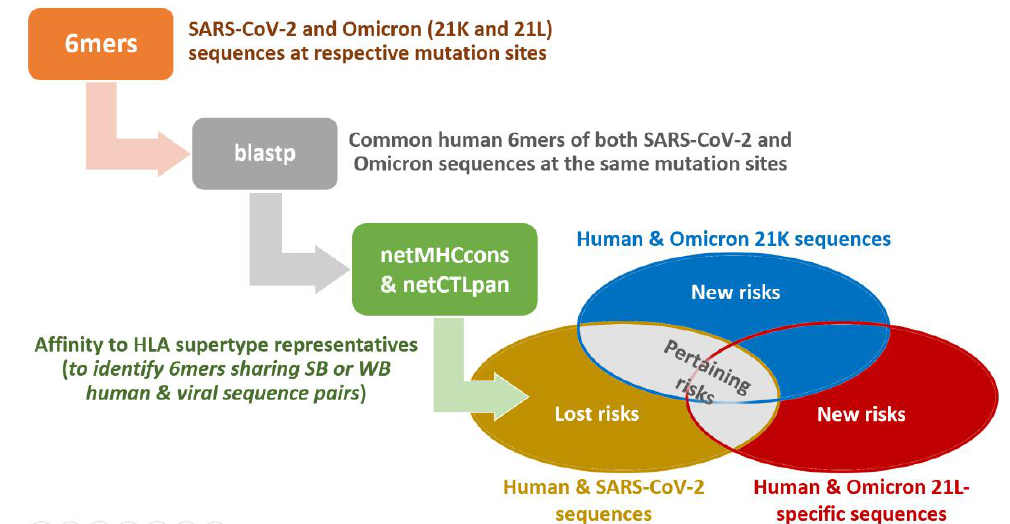
Figure 1. The outline of the methodology. We first prepared 6mer peptides at the Omicron 21K and Omicron 21L mutation sites, along with the SARS-CoV-2 peptides at the respective mutation sites, and then performed blastp searches to find human proteins containing those 6mers. Human peptides sharing 6mers with SARS-CoV-2 and Omicron sequences at the same mutation sites were selected. Selected SARS-CoV-2/human and Omicron/human peptide pairs were predicted for their binding affinities to the HLA supertype representatives, to identify strong-binder (SB) and weak-binder (WB) peptides. Those peptide pairs with such high affinities to the same alleles were evaluated as the lost cross-reaction risks in the susceptible individuals, upon infection, if they were exclusively SARS-CoV-2/human peptide pairs. Such peptide pairs were evaluated as the new, or de novo, risks, if they were exclusively Omicron/human peptide pairs. They were evaluated as pertaining risks if they were both SARS-CoV-2/human and Omicron/human peptide pairs of sequences at the same mutation sites. Omicron/human peptide pairs included Omicron sequences that were separated into Omicron 21K sequences and Omicron 21L-specific sequences, where the Omicron 21K sequences also involved sequences at mutation sites common to both Omicron 21K and Omicron 21L.